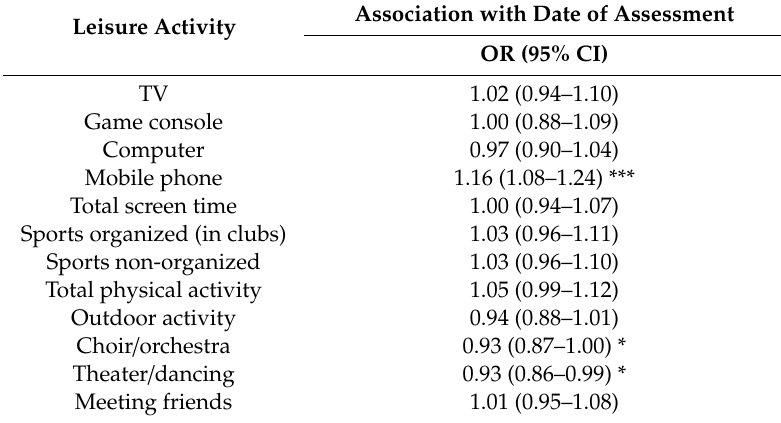
Table 3. Changes over time (2011–2017) described as associations between leisure activities and date of assessment ( N =